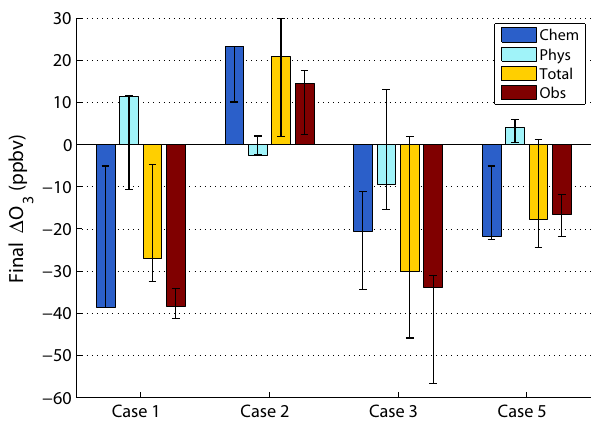
Fig. 10. 1 O 3 partitioned by process between the first and last La- Fig. 10. ∆O 3 partitionedbyprocessbetweenthefirstandlastLagrangianmatchwindowforeachcase. grangian match window for each case. Blue: 1 O 3 from chemical Blue: ∆O 3 fromchemicaltendenciesinthemodel.Cyan: ∆O 3 fromphysicalprocesstendenciesinthe tendencies in the model. Cyan: 1 O 3 from physical process tenden- model. Yellow: Total ∆O 3 inthemodel. Brown: observed ∆O 3 ,estimatedtakingintoaccountboth cies in the model. Yellow: total 1 O 3 in the model. Brown: observed upstreamanddownstreamvariability. Theblue,cyanandyellowbarsshowthebestcasesimulation; 1 O 3 , estimated taking into account both upstream and downstream errorbarsencompassthefullrangeofthesensitivitytests,andtakeintoaccounttheensemblespread for ∆O 3 . variability. The blue, cyan and yellow bars show the best case sim- ulation; error bars encompass the full range of the sensitivity tests, and take in to account the ensemble spread for 1 O 3 53